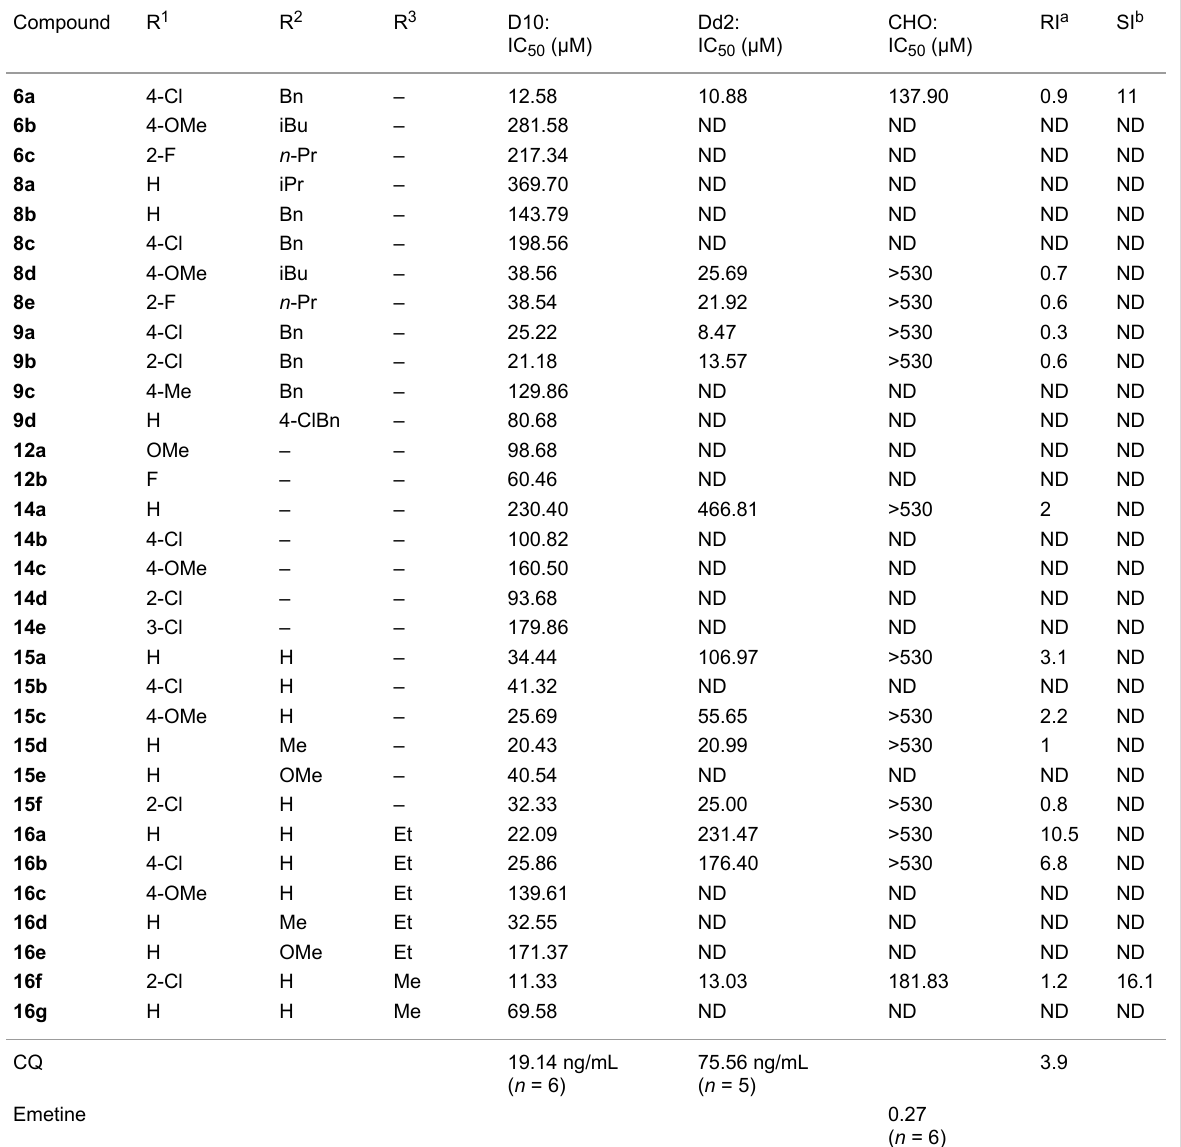
Table 1: IC 50 -values of compounds 6 , 8 , 9 , 12 , 14 , 15 and 16 tested for in vitro antiplasmodial activity and